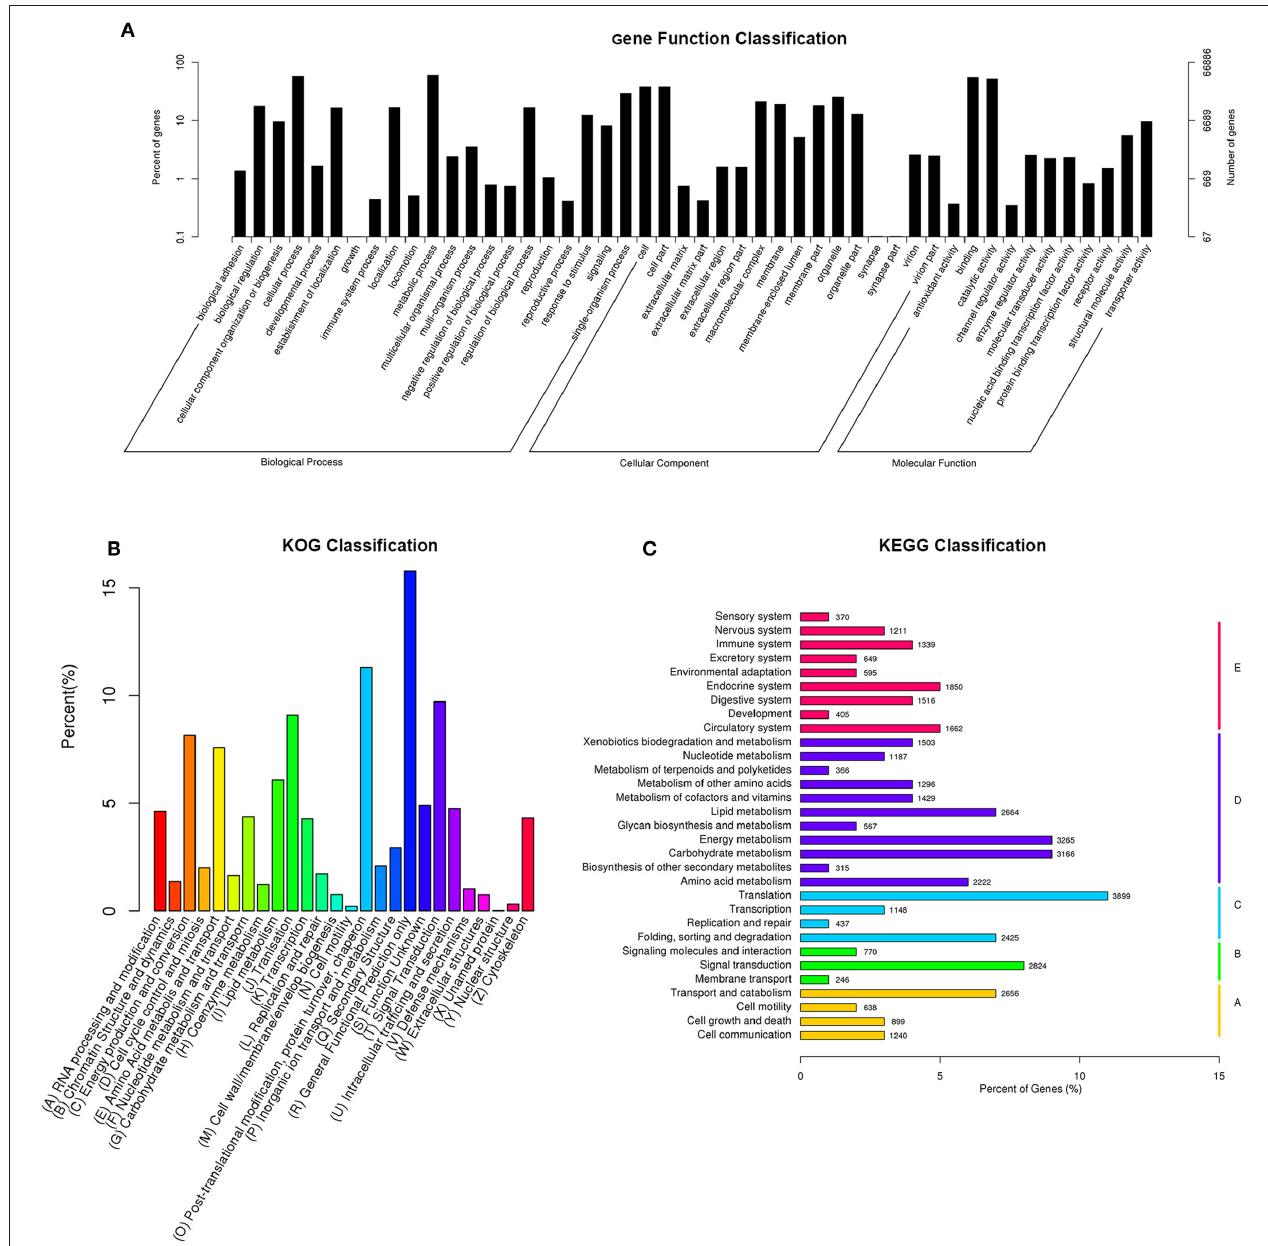
FIGURE 1 | Histogram of gene ontology classification (A) , Clusters of Orthologous Groups of proteins (B) , and KEGG Ortholog database (C) . (A) The results are summarized in three main categories: biological process, cellular Component, and molecular function. The right y-axis indicates the number of genes in a category. The left y-axis indicates the percentage of a specific category of genes in that main category. (B) The X-axis indicates 26 group categories; the Y-axis indicates the percentage of a specific category of genes in that main category. (C) The Y-axis is the enrichment of the KEGG term, the X-axis indicates the percentage of a specific category of genes in that main category. According to participation in KEGG metabolic pathways, genes can be divided into five branches: A, cellular processes; B, environmental information processing; C, genetic-based information processing; D, metabolism; E, organismal